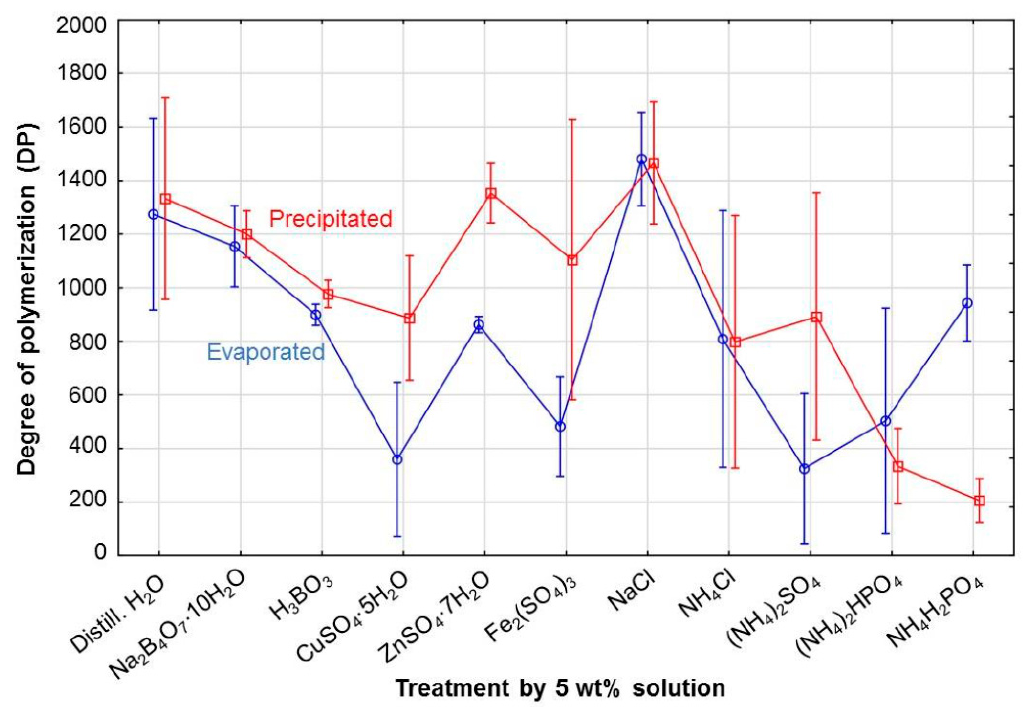
Figure 3. Influence of solution*method on the degree of polymerization in cellulose.